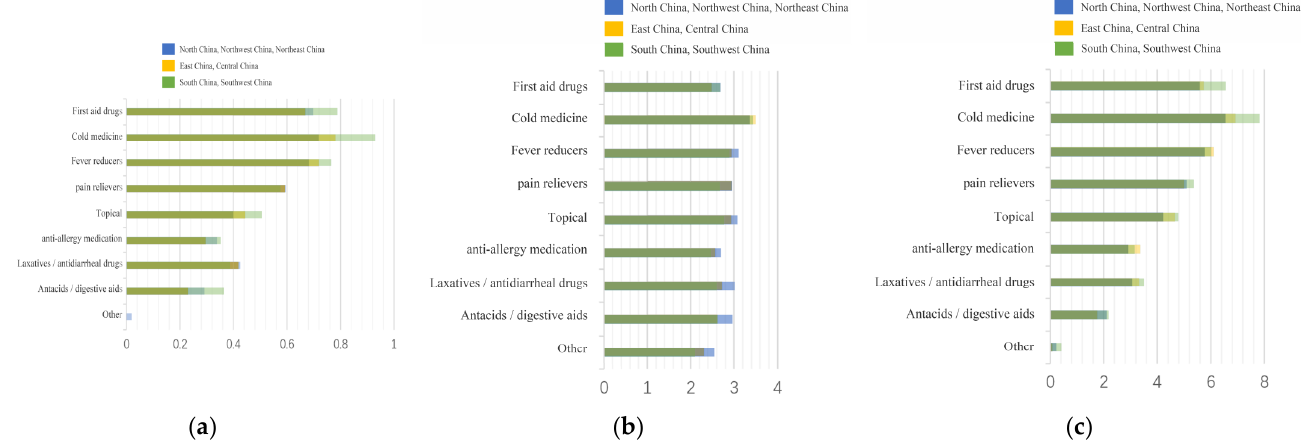
Figure 7. Summary of drug stockpiles, frequency of drug use, and ranking of drug importance in different regions. ( a ) Stockpile, ( b ) Frequency, ( c ) Rank.